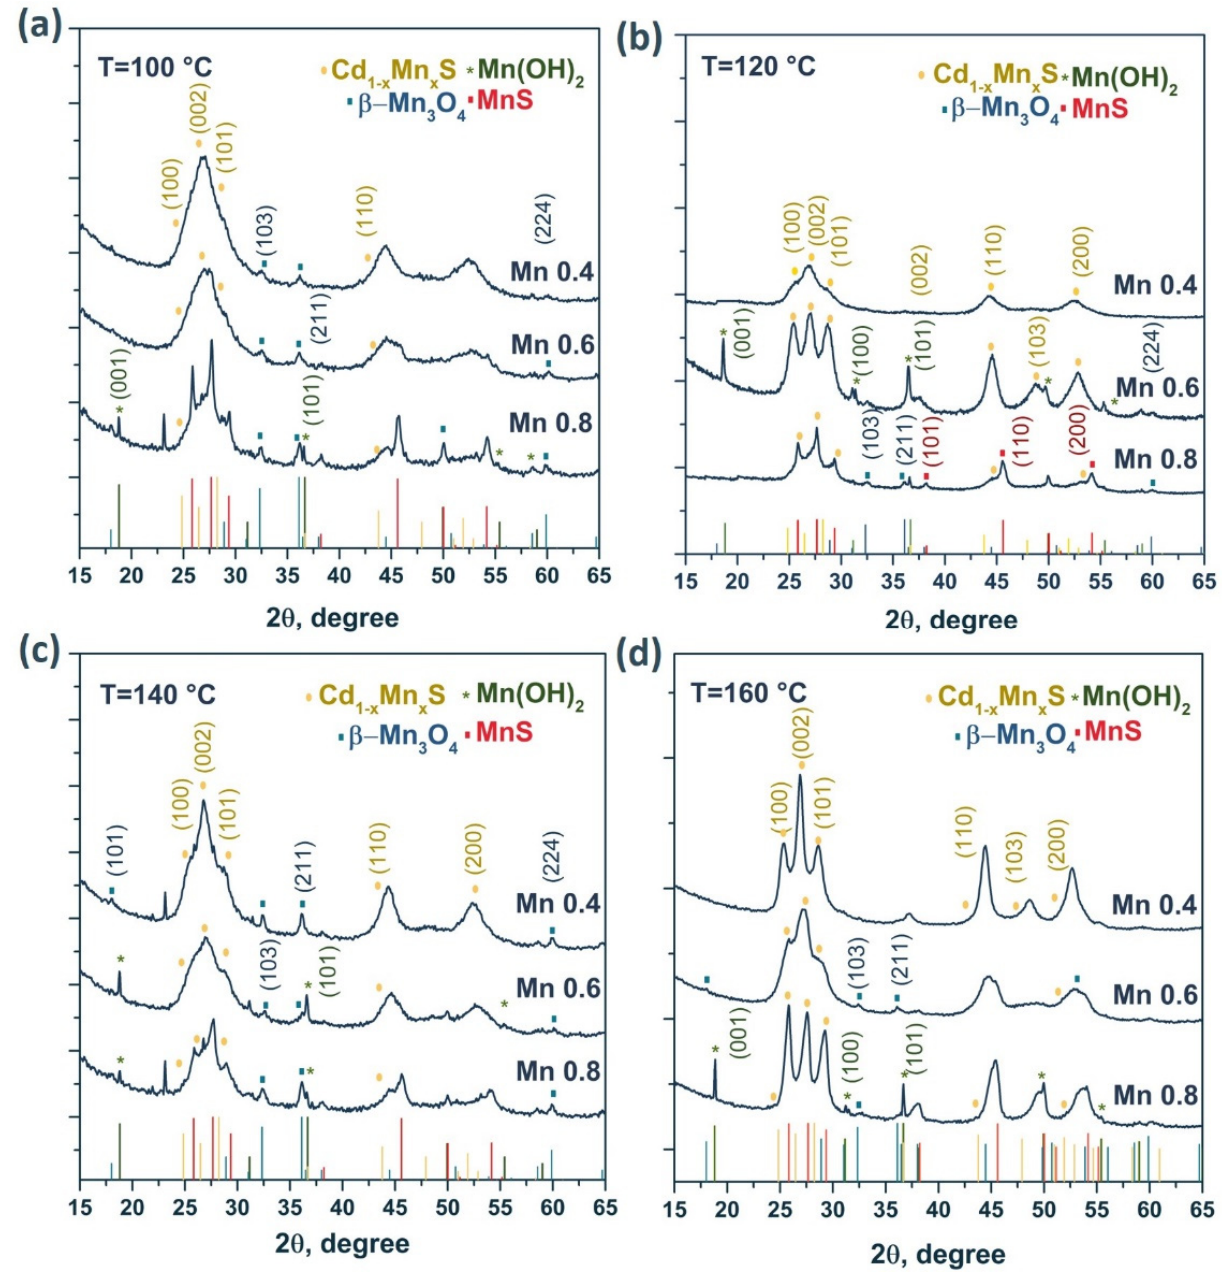
Figure 2. XRD patterns of the samples Cd 1 − x Mn x S with different manganese content for the HT100— HT160 series ( a – d ).